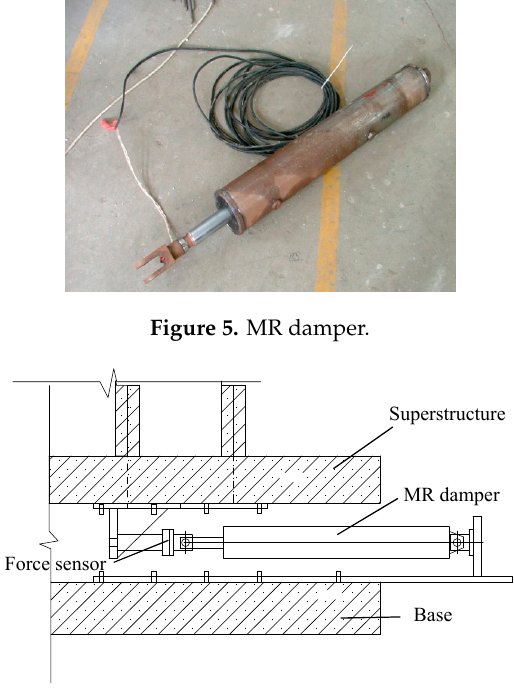
Figure 6. Connection diagram of damper in isolation layer.